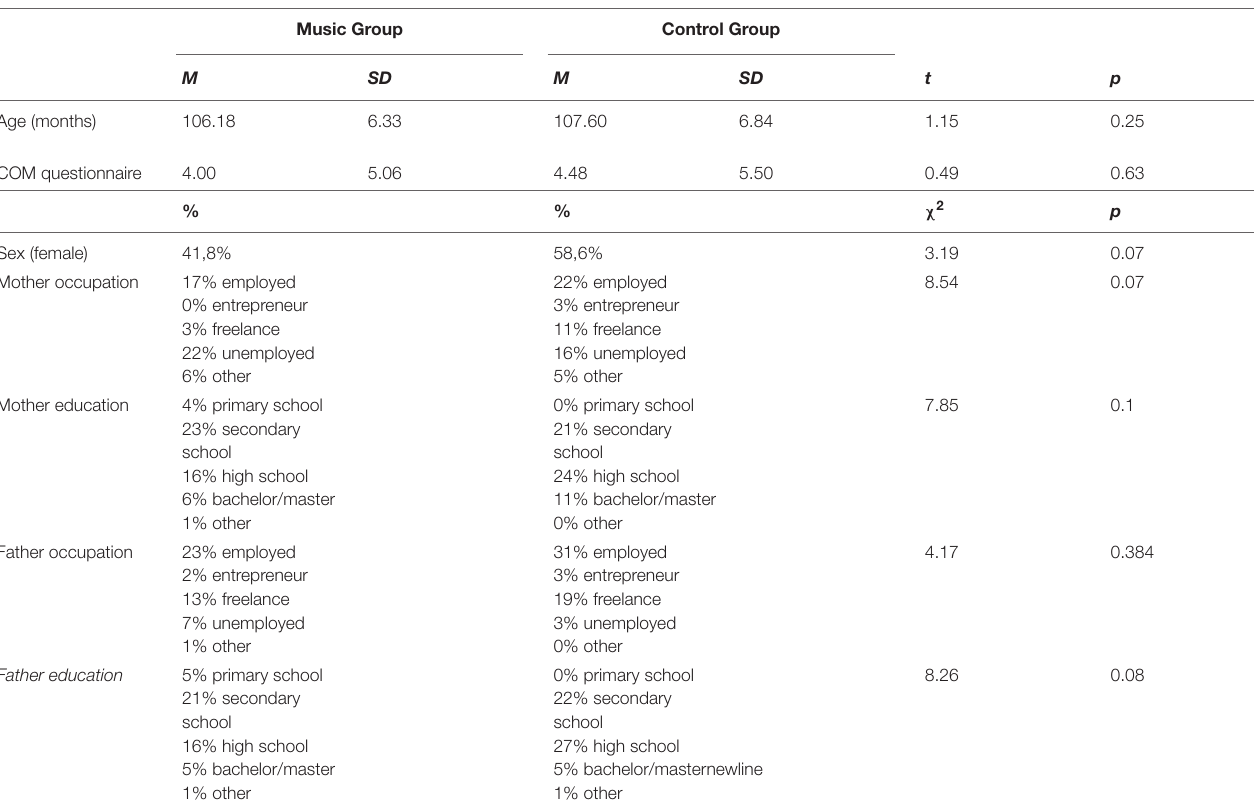
TABLE 1 | Demographic details of the children and their parents at